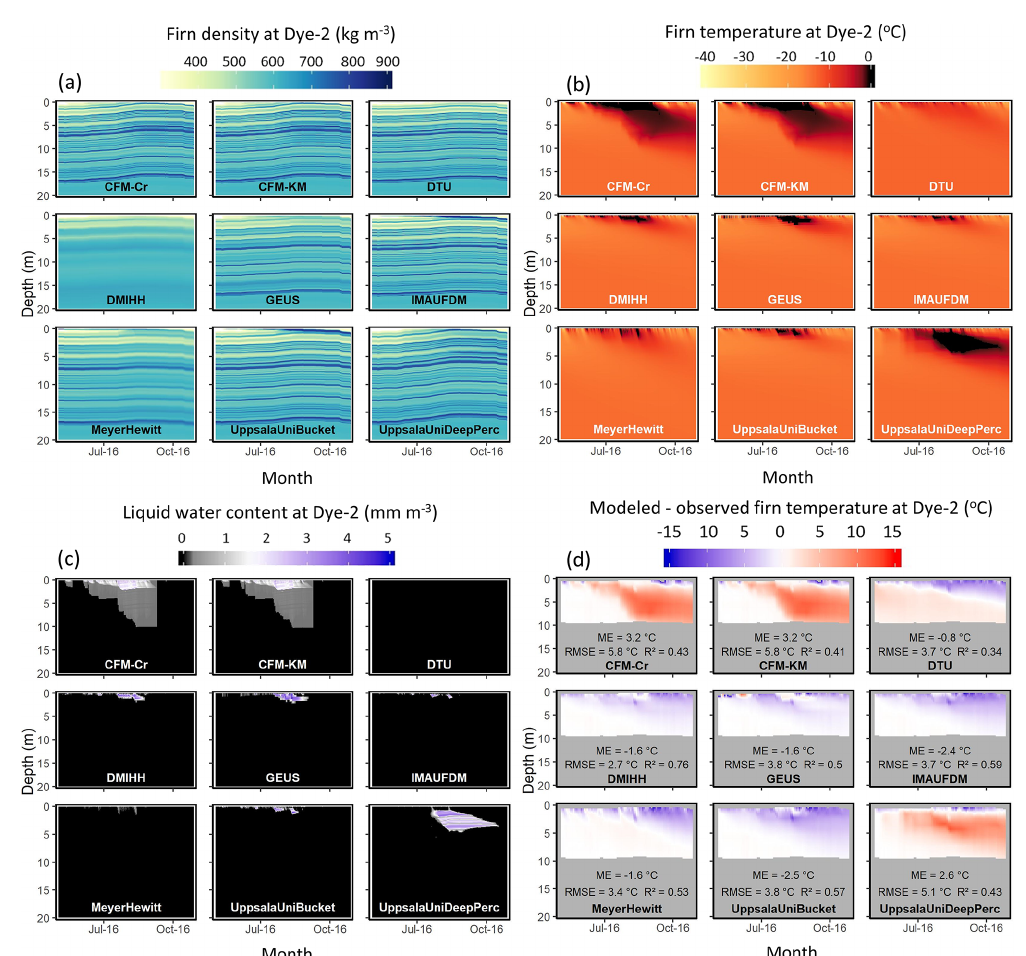
Figure 6. Simulated firn density (a) , temperature (b) , water content (c) , and deviation between simulated and observed firn temperature (d) at Dye-2_16.